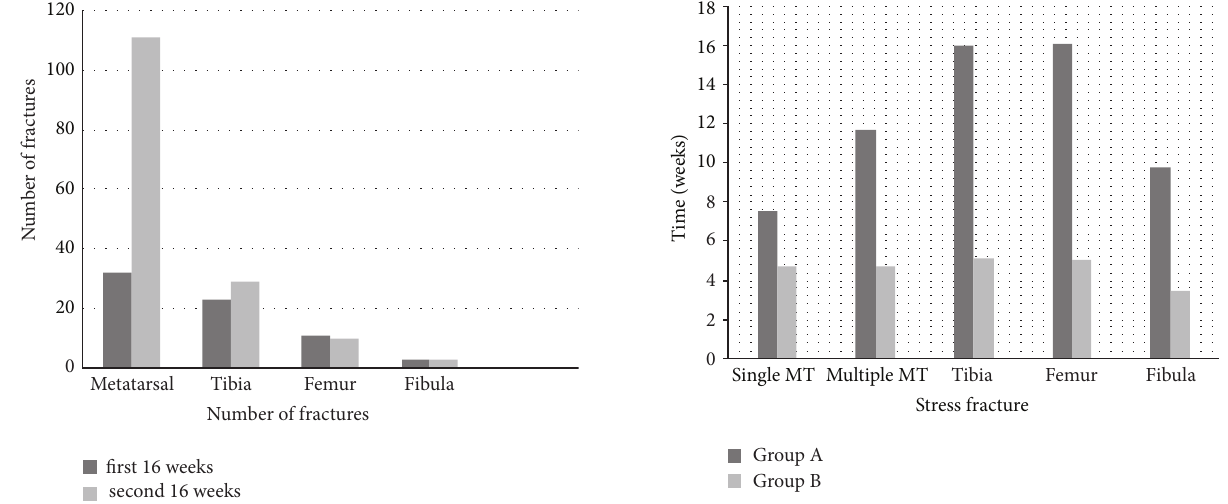
Figure 1: Time of occurrence of stress fracture and anatomical distribution.